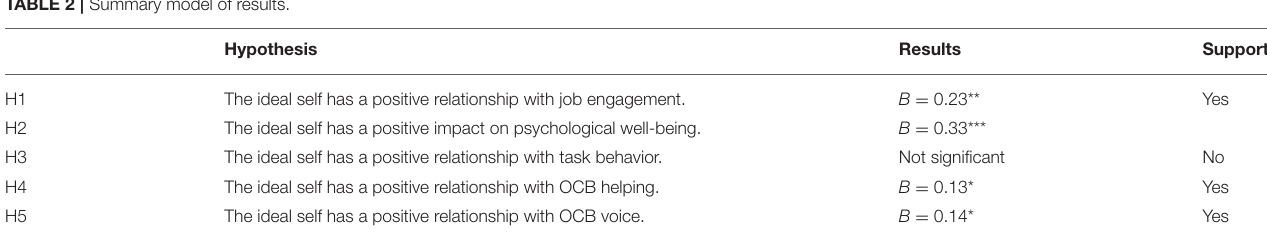
TABLE 2 | Summary model of results.